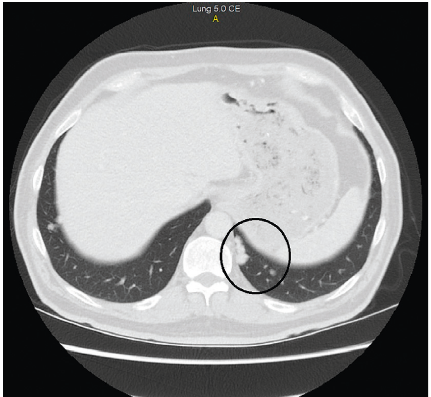
Figure 4: PET scan correlated CT section of lung nodule on day 45 of the vemurafenib treatment.